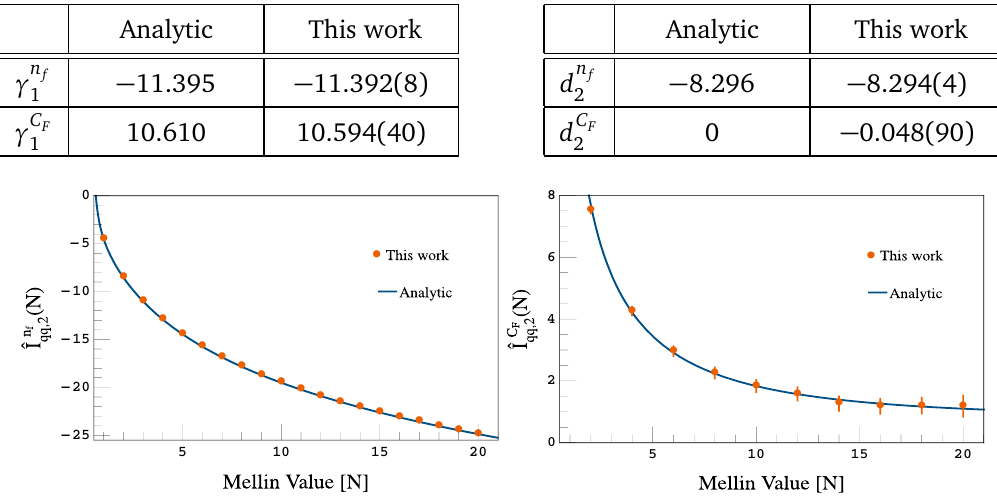
Analytic This work n f − 8.296 − 8.294 ( 4 ) d 2